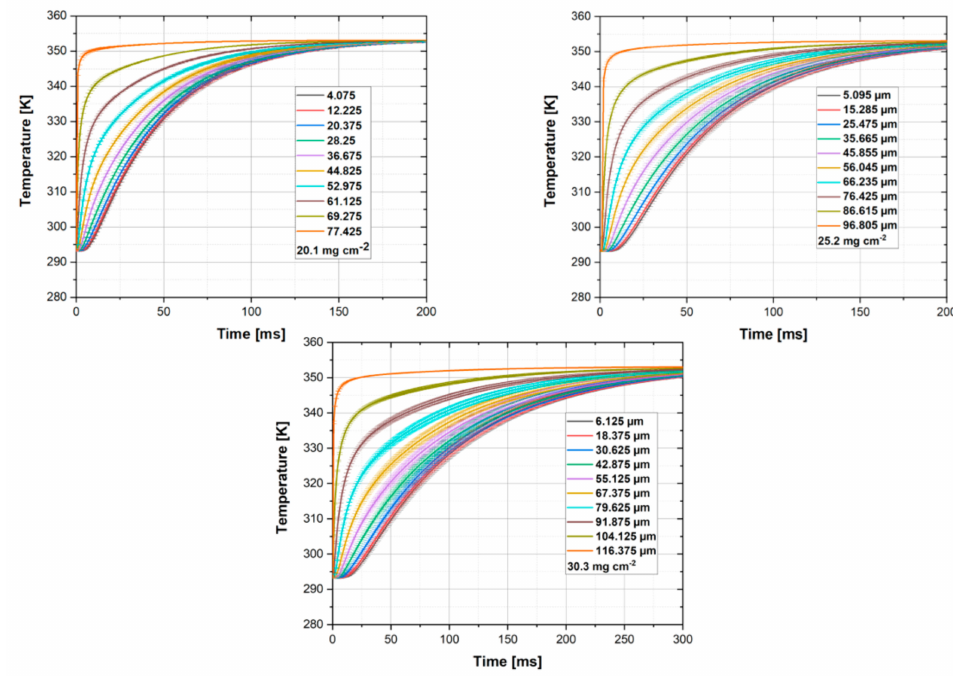
Figure 5. Temperature at different positions (see legend) along the electrode height for different areal